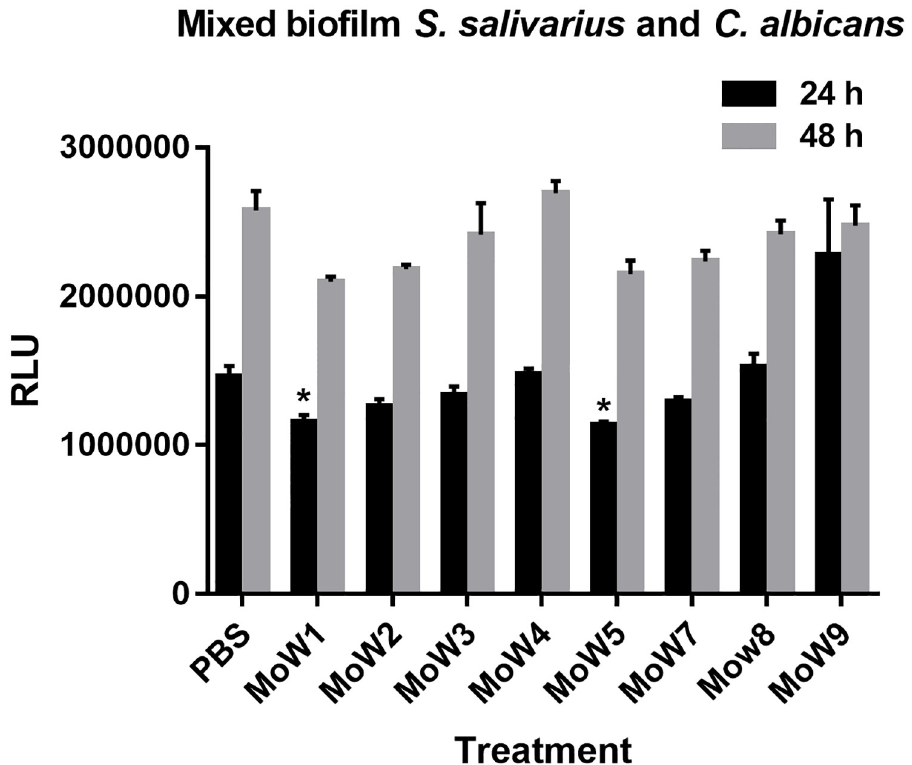
Fig 6. Effect of MoWs-pretreated S . salivarius on C . albicans capacity to form biofilm. S . salivarius isolate 12 was treated for 1 minute with PBS or with MoWs, before being washed, suspended in cF12 and seeded (1.5 x 10 7 CFU/ml) together with untreated C . albicans cells (2 x 10 6 /ml) onto a TR146 epithelial cells monolayer. The plates were then incubated at 37˚C and BLI C . albicans biofilm biomass was then assessed by bioluminescence at 24 hours (black columns) and 48 hours (grey columns). Each result is the mean value ± standard error of triplicate samples. � p < 0.05 indicate significant differences between MoWs-treated vs PBS-treated bacteria. MoW1: Curasept 0.20; MoW2: Dentosan Collutorio; MoW3: Meridol Collutorio; MoW4: Elmex Sensitive Professional; MoW5: Listerine Total Care Zero; MoW7: Parodontax; MoW8: Oral B; MoW9: PlaKKontrol Protezione